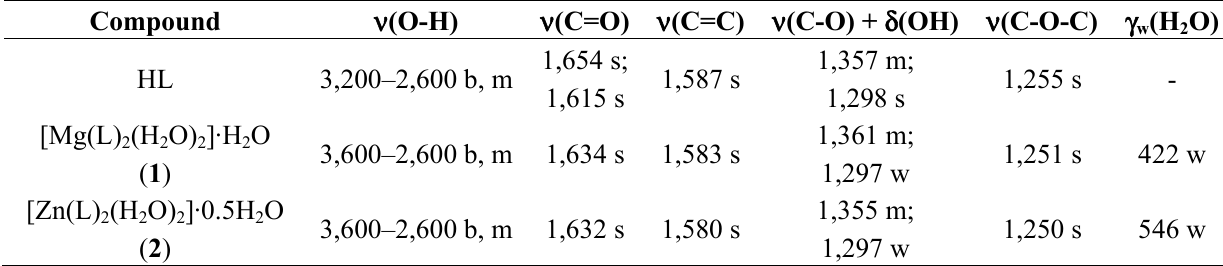
Table 3. IR data (cm − 1 ) for ligand and